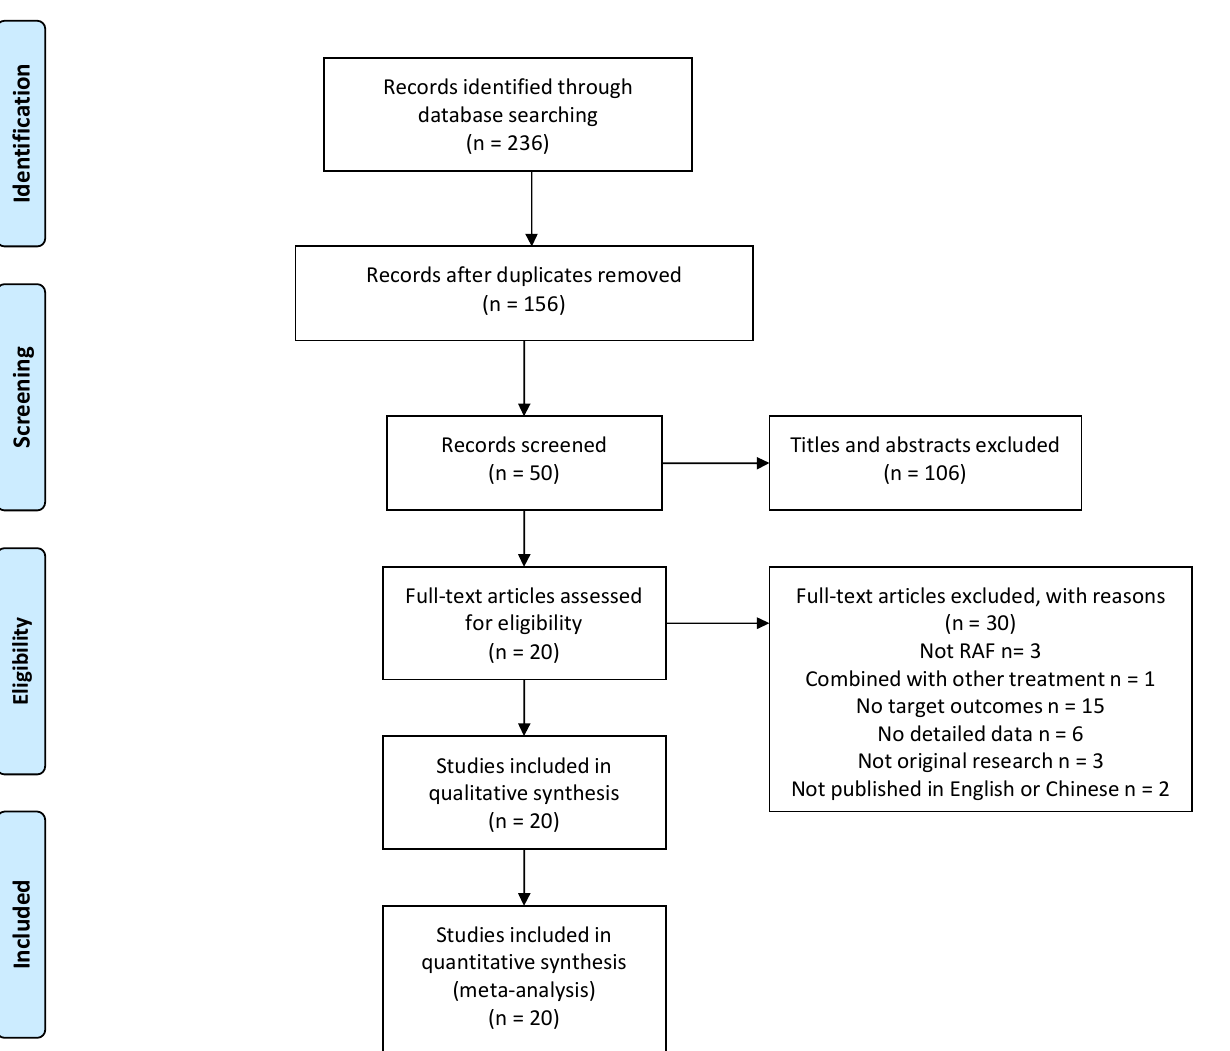
Figure 1. Preferred Reporting Items for Systematic Reviews and Meta-Analyses flowchart of systematic review.